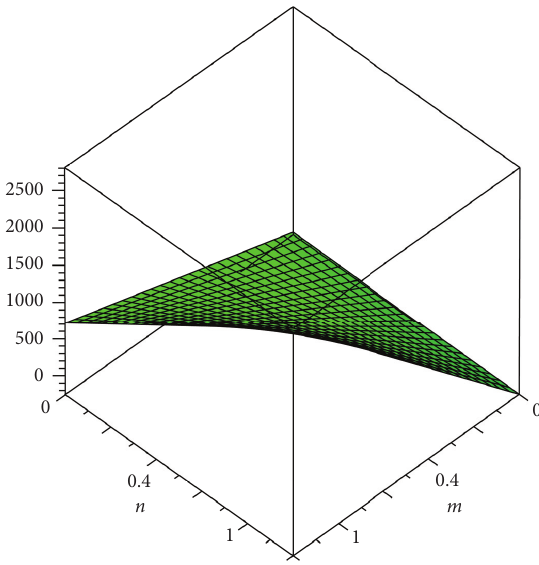
Figure 26: Plots of the first hyper-Gourava index for m − Bil